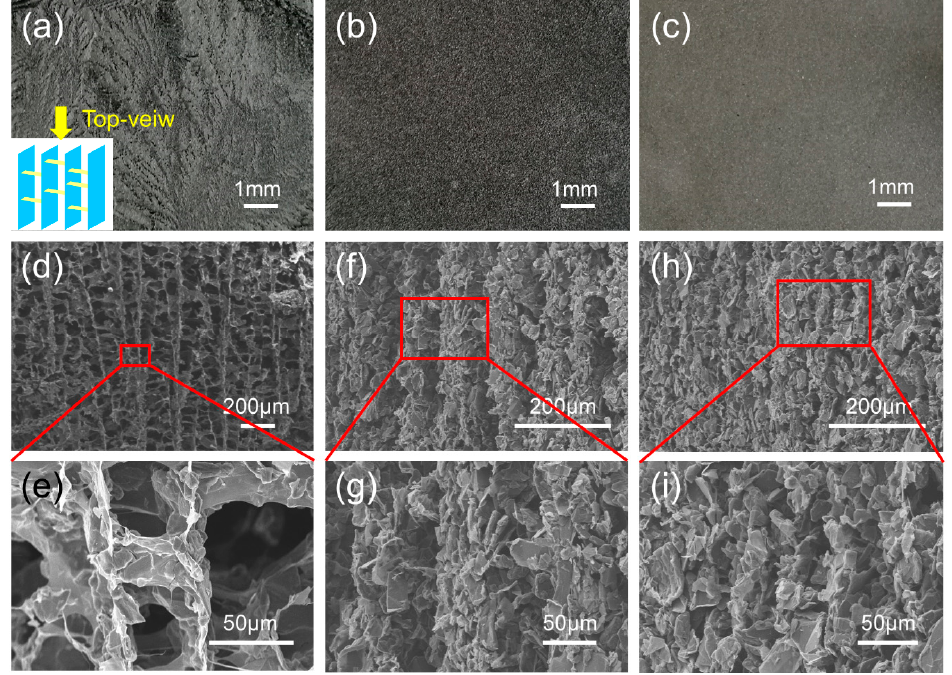
Figure 3. ( a – c ) Top-view digital images of 3D-GP skeletons with freezing temperatures of − 5 ◦ C, − 60 ◦ C, and − 196 ◦ C, respectively. Inset is the illustration of top-view direction. ( d – i ) Side-view SEM images of 3D-GP skeletons and their magnifications with freezing temperatures of − 5 ◦ C, − 60 ◦ C, and − 196 ◦ C, respectively.